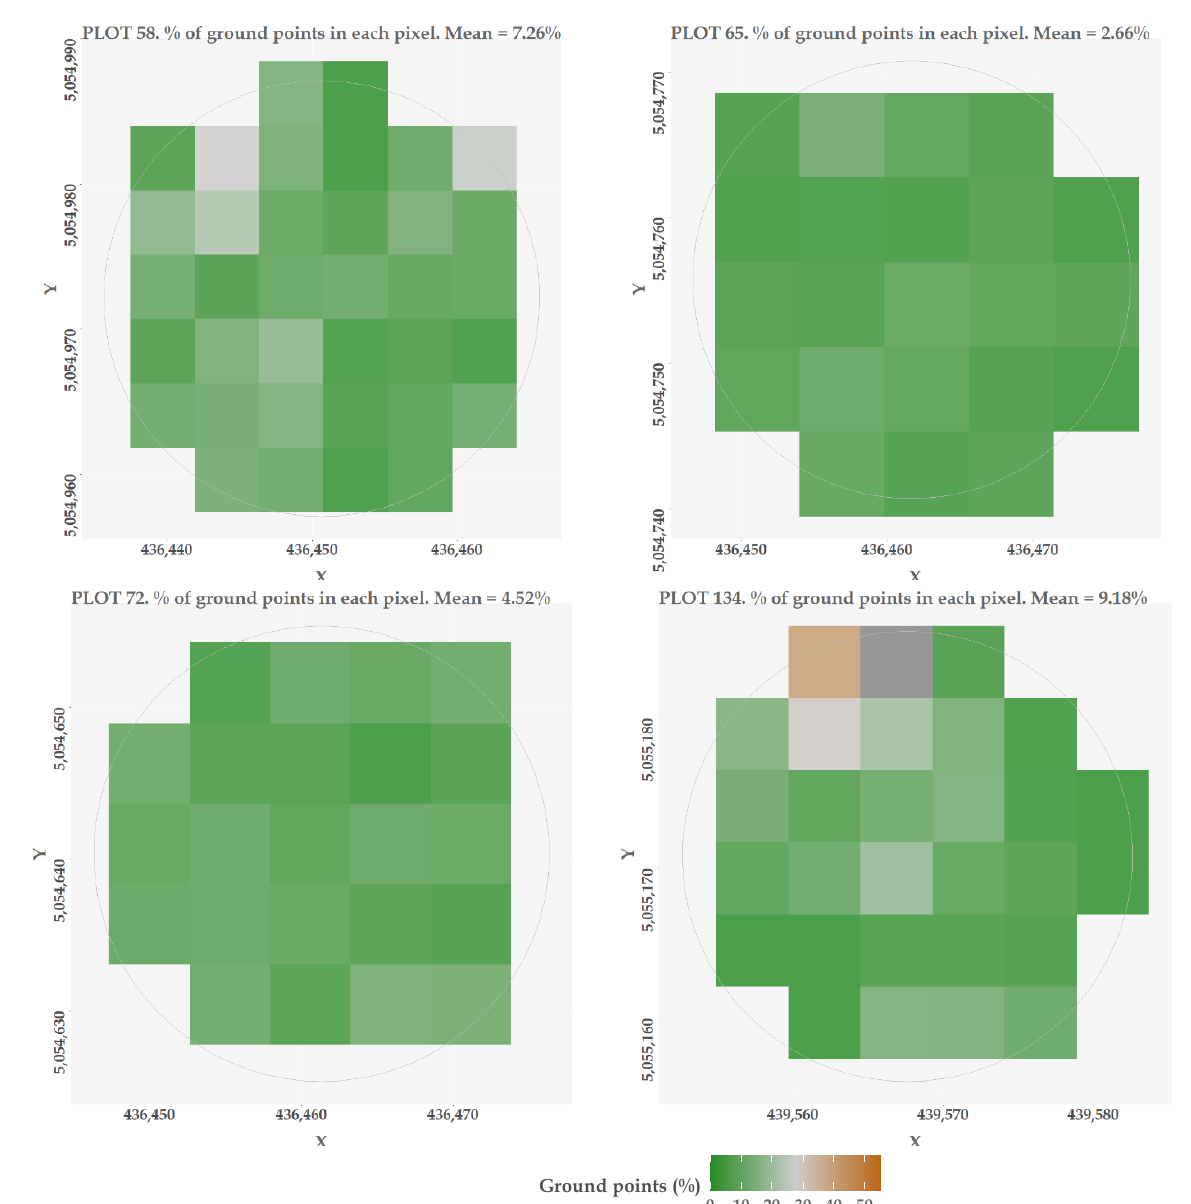
Figure A3 . Percentage of ground points at the pixel level. Figure A3. Percentage of ground points at the pixel